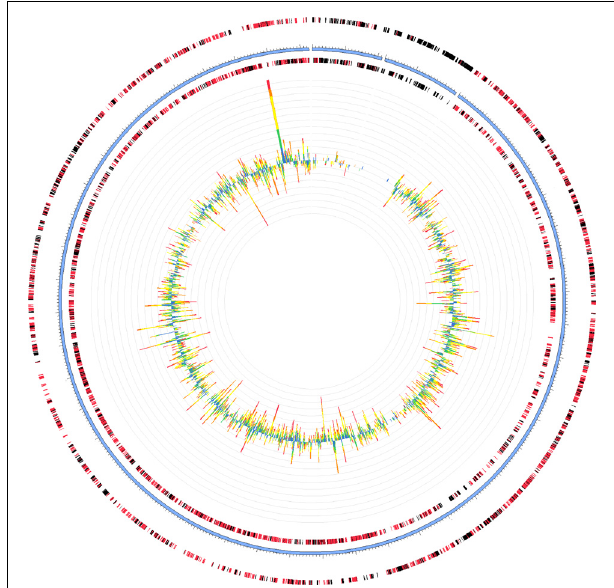
( Figure 4 ), toluene, and benzoate pathways (Supplemental Figure S4B) mapped to members of the Rhodobacterales and